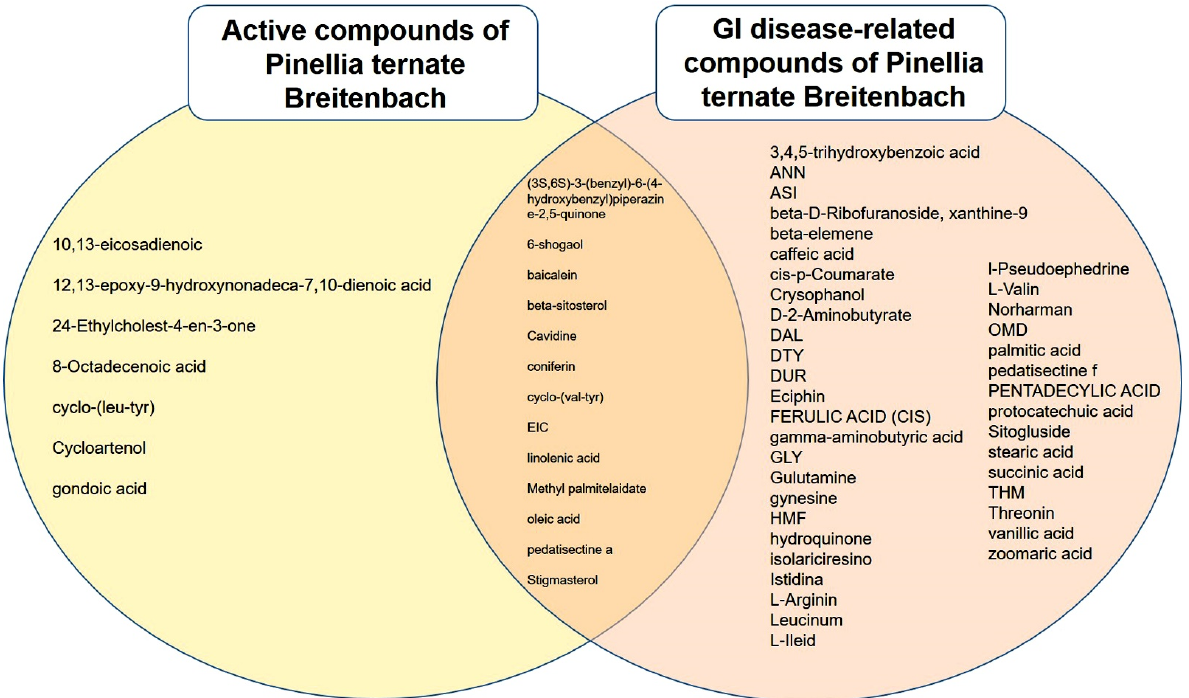
Figure 3. Venn diagram of the interactions between active compounds and gastrointestinal (GI) disease-related compounds in Pinellia ternate Breitenbach